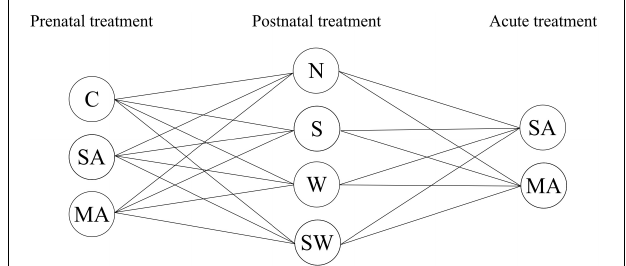
FIGURE 1 | Overview of groups used in the present study. Prenatal treatment: C, control; SA, saline; MA, methamphetamine. Postnatal treatment: N, non-stressed controls; S, maternal separation; W, maternal cold water swimming stress; SW, maternal separation plus maternal cold water swimming stress. Acute SA indicates a single direct saline injection prior to testing, and acute MA indicates a single direct methamphetamine injection prior to